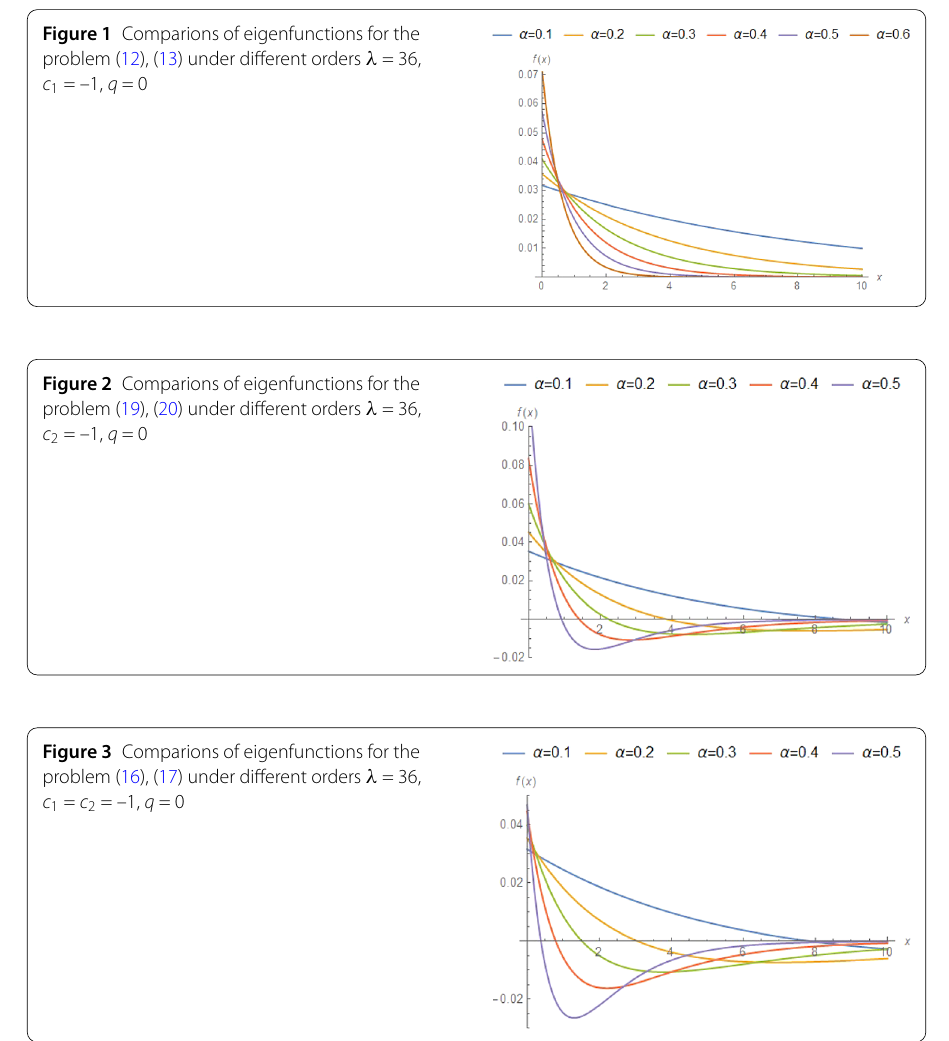
Figure 1 Comparions of eigenfunctions for the problem (12), (13) under different orders λ = 36, c 1 = –1, q = 0